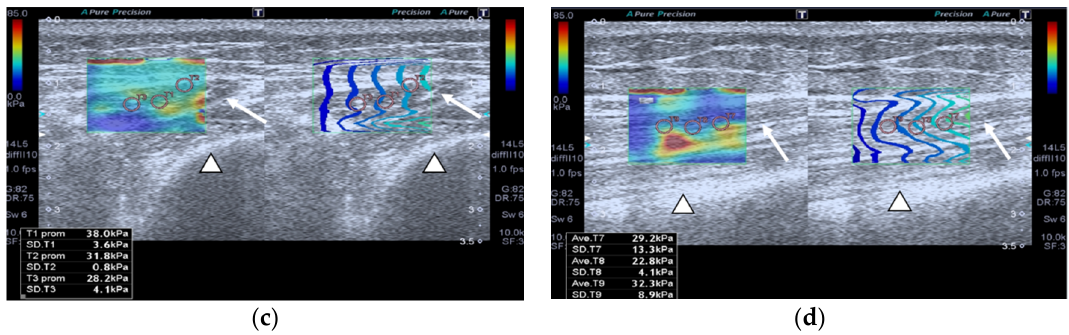
Figure 1. Quadriceps rectus femoris (QRF) muscle ultrasound (US) scan and shear wave elastography (SWE) with several regions of interest (ROIs) (pink circles) measured across the muscle of a matched healthy control (63 years old). SWE shows high muscle elasticity. ( a ) Transversal QRF muscle (arrow) US scan, femur (arrowhead); ( b ) longitudinal QRF muscle (arrow) US scan, femur (arrowhead). Patient with multiorgan failure (67 years old). SWE shows muscle stiffness with several regions of interest (ROIs) (pink circles). ( c ) Transversal QRF muscle (arrow) US scan, femur (arrowhead); ( d ) longitudinal QRF muscle (arrow) US scan, femur (arrowhead).